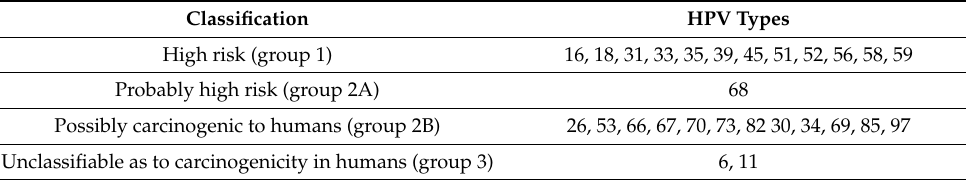
Table 1. HPV classification according to the oncogenic risk